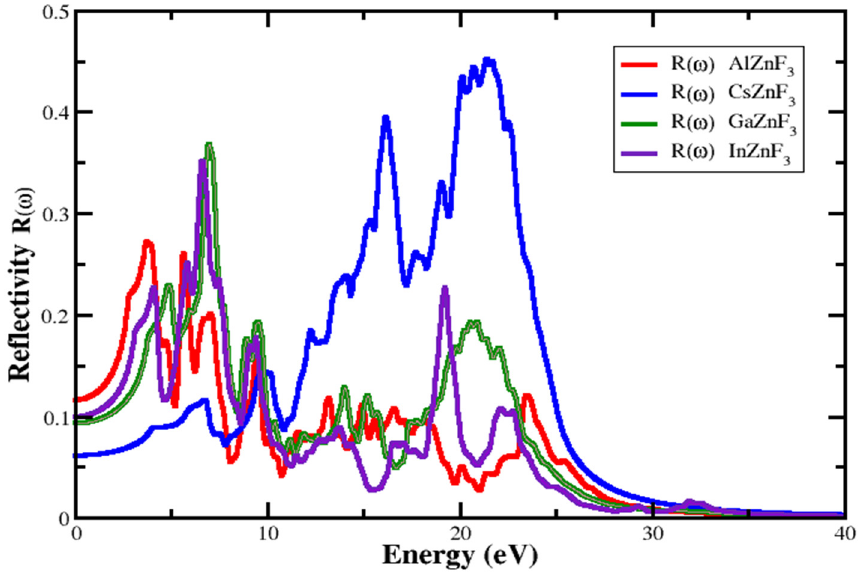
Figure 9. Reflectivity of XZnF 3 (X = Al, Cs, Ga, In).